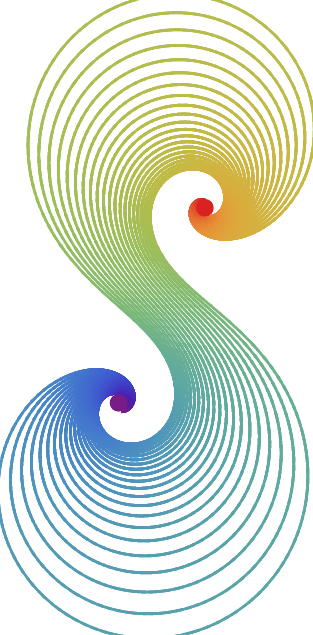
JHEP08(2019)123